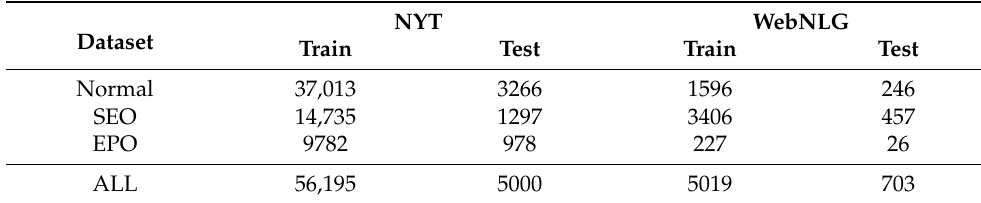
Table 1. Statistics of NYT and